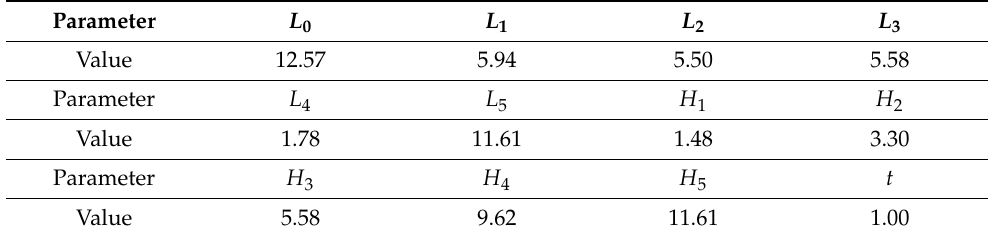
Table 1. Dimensions (mm) of the square waveguide septum